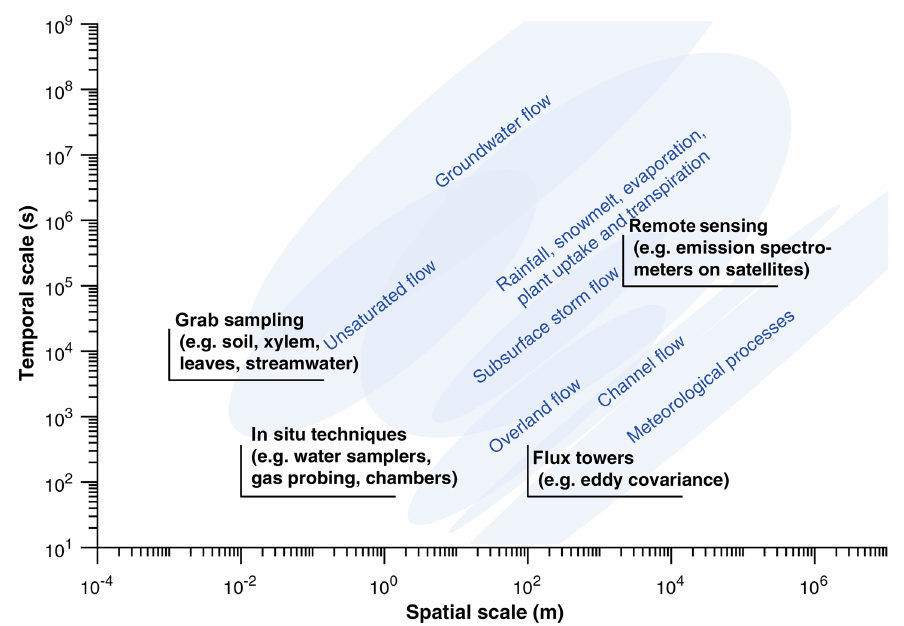
Figure 1. Simplified representation of spatial and temporal scales of ecohydrological processes (based on Blöschl and Sivapalan, 1995 and Bowen and Good, 2015) and of isotope observational techniques frequently used to characterize these processes. Method scales represent typical minima that may be expanded through multiple observations, and process scales approximate characteristic scales of variation. While recent developments in sample acquisition and analytical techniques have increased sample throughput and pushed the limits of observational capacity, a lack of ability to immediately characterize heterogeneous hydrological and ecological processes at typical study scales is glaringly apparent. As a consequence, large uncertainty and interpretation errors can result in isotopic studies, and open questions exist regarding appropriate sampling